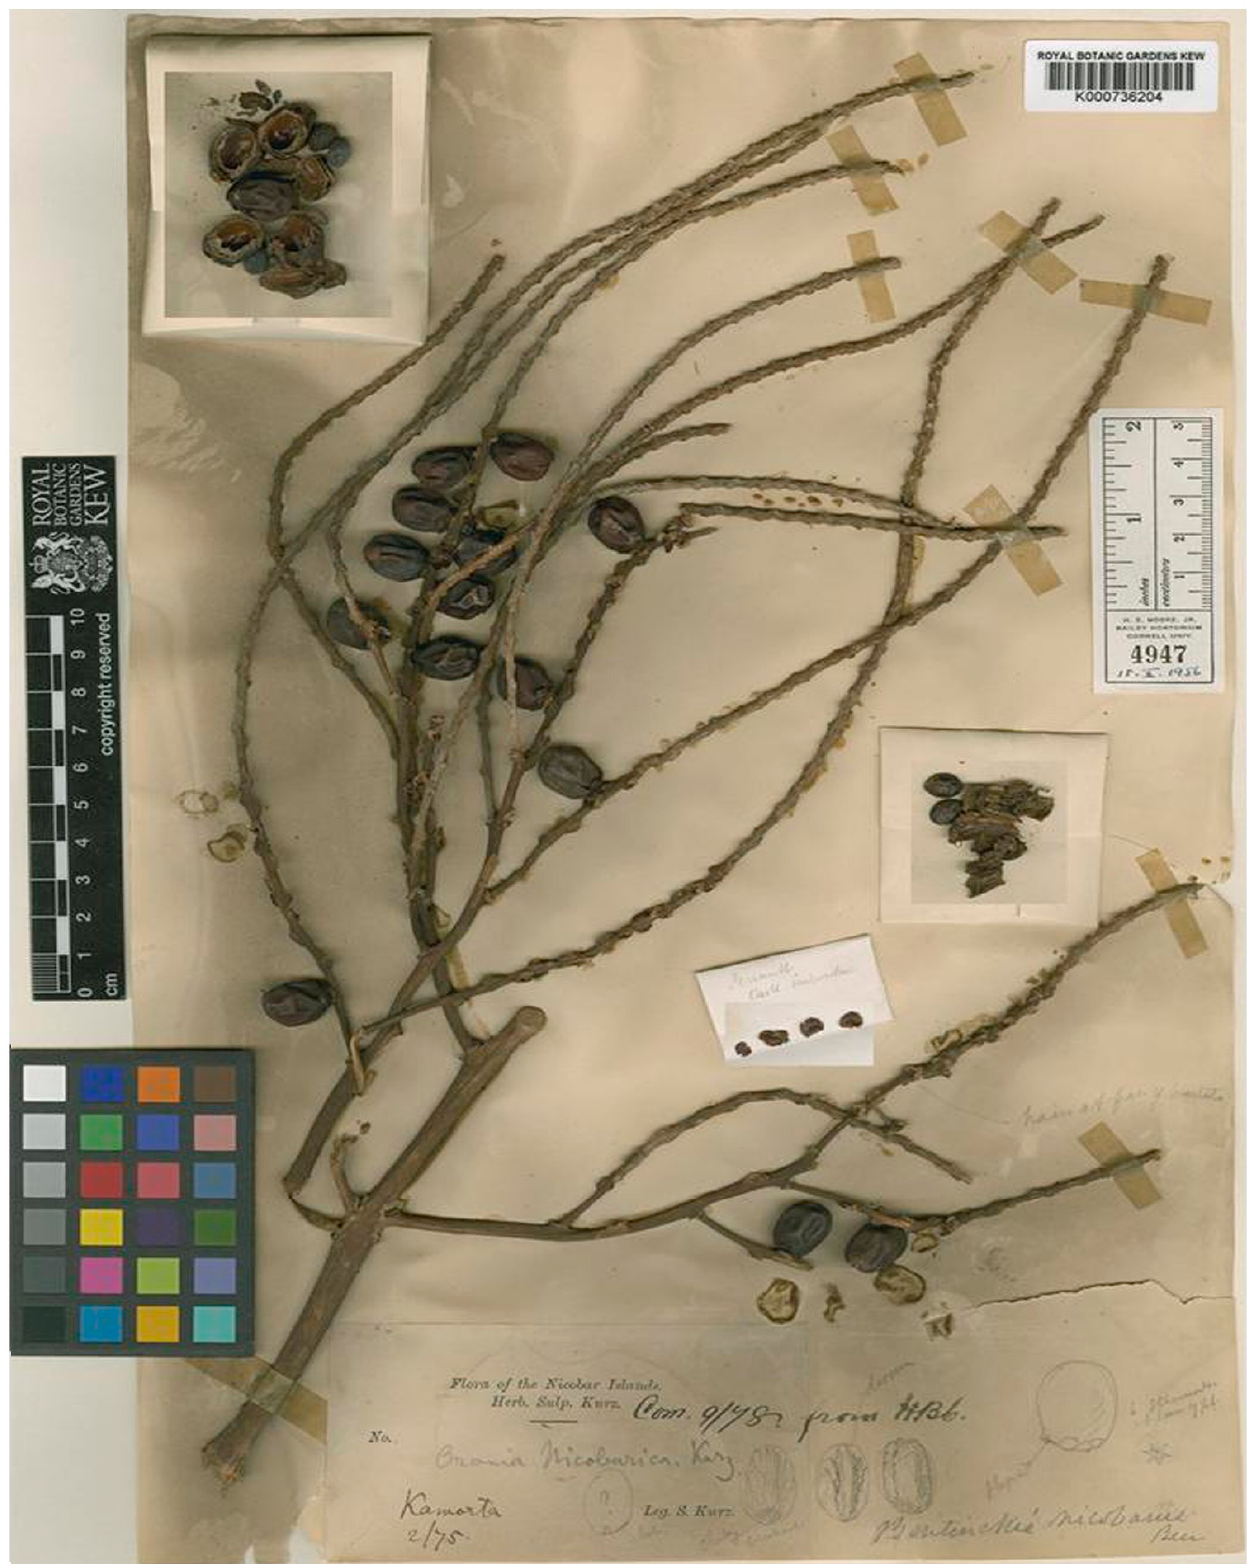
Figure 9. Lectotype of Orania nicobarica Kurz ( ≡ Bentinckia nicobarica (Kurz) Becc.) (K000736204). © Royal Botanic Gardens, Kew.